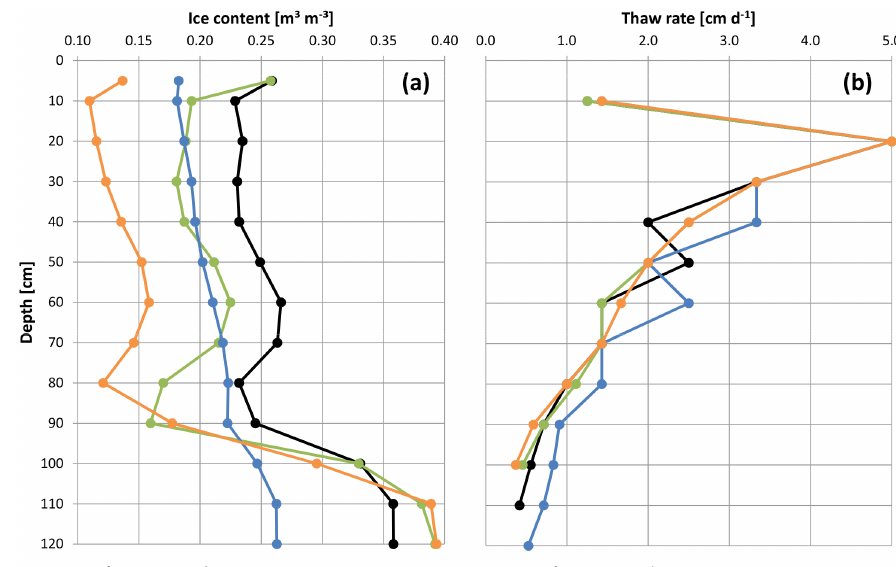
Figure 5. Comparison of (a) simulated ice content distribution with depth at the end of winter 2011 (1 May 2011) and (b) the corresponding modelled rate of active layer thaw starting after the first day of positive ground surface temperatures (25 May 2011), exemplified by four selected model